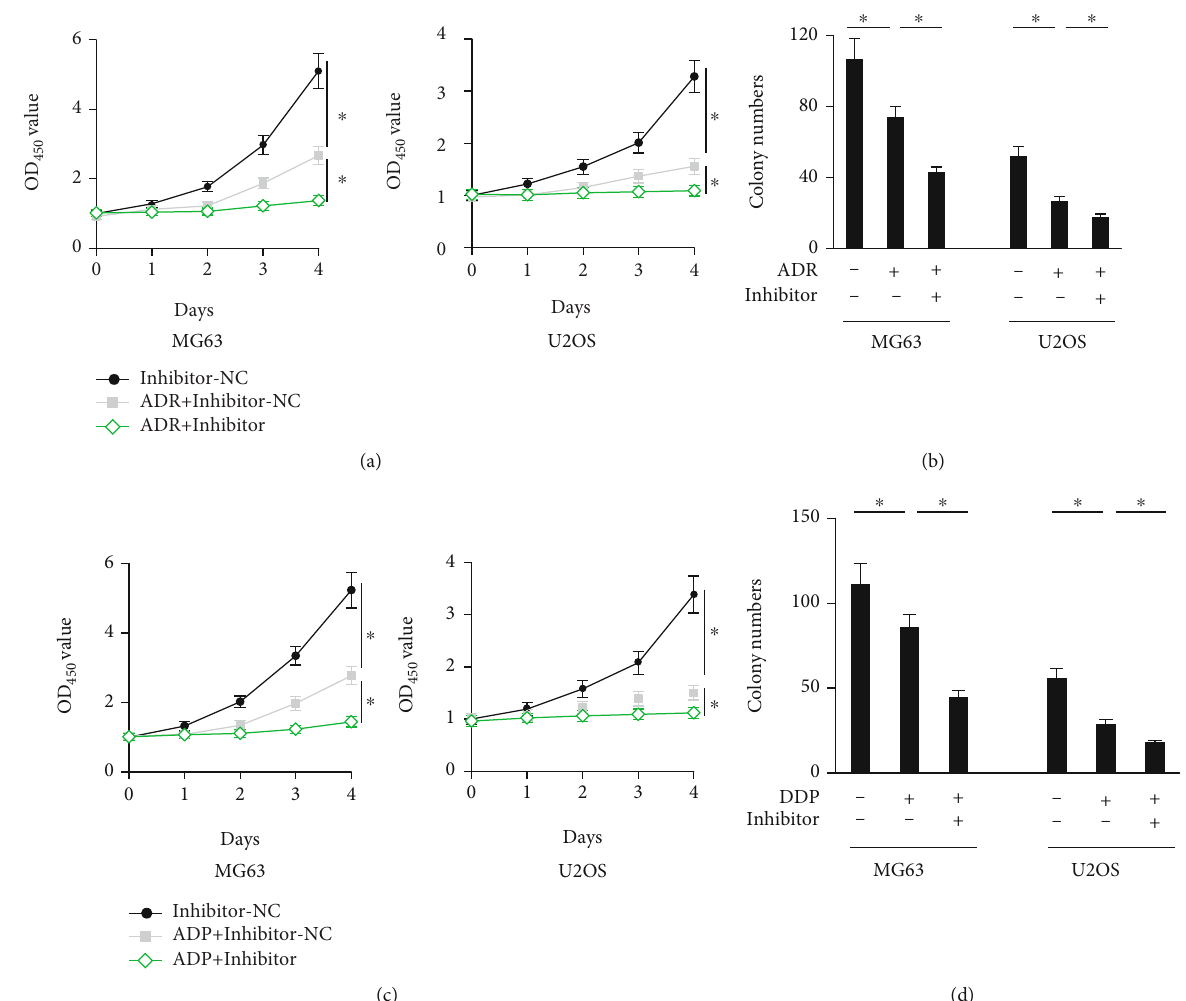
Figure 5: miR-181a-5p inhibitor further inhibits growth of osteosarcoma in vitro in the presence of classic chemotherapeutic agents. (a) Cell viability of osteosarcoma cells determined by CCK-8 assay ( n = 6 ). (b) Colony numbers in ADR-treated osteosarcoma cells with or without miR-181a-5p inhibitor incubation ( n = 6 ). (c) Cell viability of osteosarcoma cells determined by CCK-8 assay ( n = 6 ). (d) Colony numbers in DDP-treated osteosarcoma cells with or without miR-181a-5p inhibitor incubation ( n = 6 ). All data are presented as the mean ± SD , ∗ P < 0 : 05 versus the matched